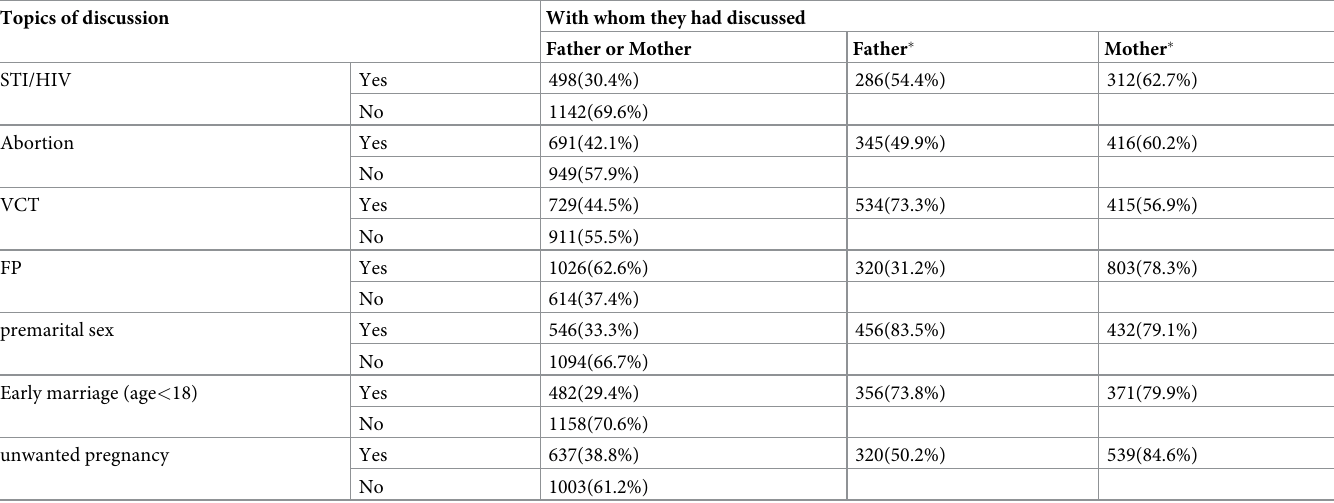
Table 3. Primary and Secondary school night female student’s discussion with their parents on SRH issues in the last 6 months in Amhara Region, Ethiopia